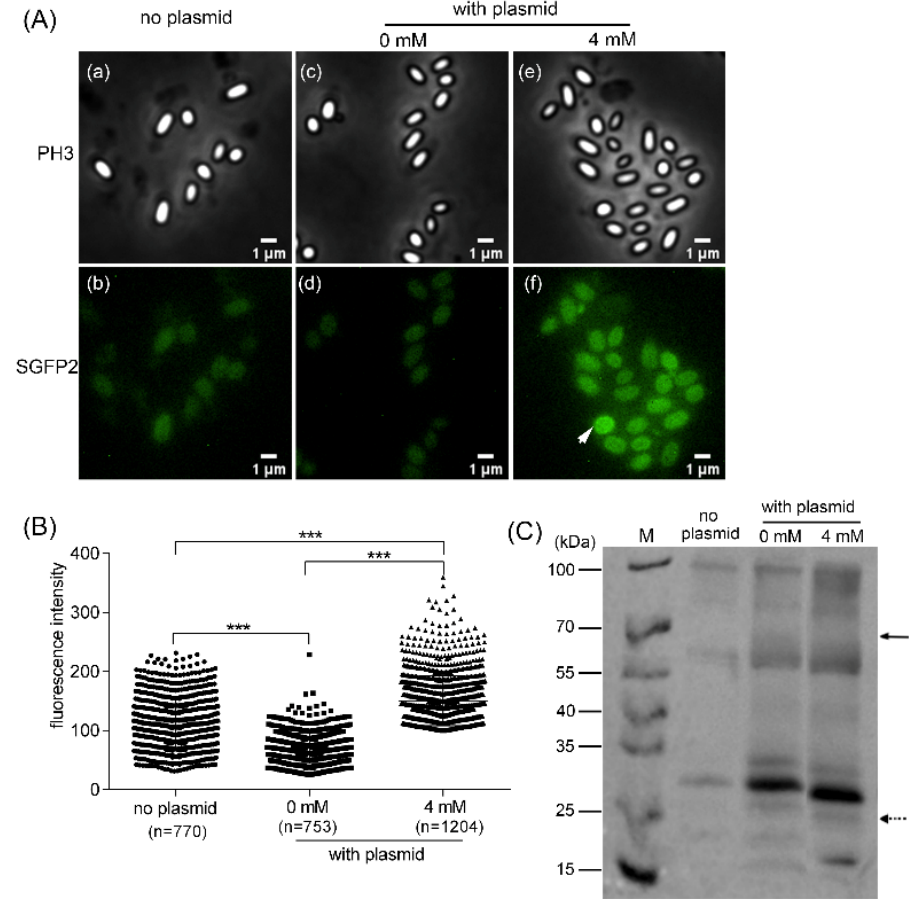
Figure 5. Imaging using phase contrast (PH3) or fluorescence (SGFP2) microscopy of GerRB-SGFP2 in B. cereus spores with or without plasmid pDG148- gerRB - SGFP2 and prepared with or without 4 mM IPTG. ( A ) Visualization of dormant spores of B. cereus . Panels Aa and Ab—wild type B. cereus (no plasmid) spores. Panels Ac and Ad—dormant plasmid-containing spores prepared without IPTG. Panels Ae and Af—dormant spores containing plasmid and prepared with 4 mM IPTG. Panels Aa, Ac, and Ae—phase contrast images. Panels Ab, Ad, and Af—SGFP2 green fluorescence. ( B ) The fluorescence intensity of many hundreds of individual wild type and plasmid-carrying spores, the latter prepared with or without IPTG. ( C ) Western blot analysis of levels of GerRB-SGFP2 in spores. Lane M, PageRuler™ Pre-stained Protein Ladder; no plasmid lane—total protein of wild type spores; 0 mM lane—total protein of spores with plasmid and prepared without IPTG; 4 mM lane—total protein of spores with plasmid and prepared with 4 mM IPTG. The white arrow in panel A denotes a spore with high fluorescence. The black arrow in panel C denotes the expected location of the GerRB-SGFP2 fusion protein. The dotted arrow in panel C denotes the possible location of protein SGFP2. Statistical significance in panel B was calculated by one-way analysis of variance; *** p < 0.001.